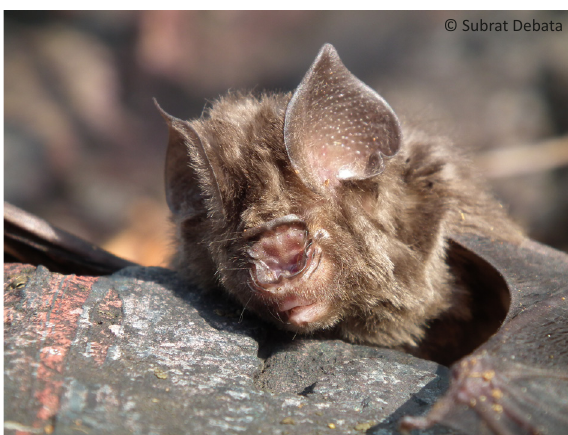
Image 2. Head of Hipposideros galeritus showing two pairs of sup-